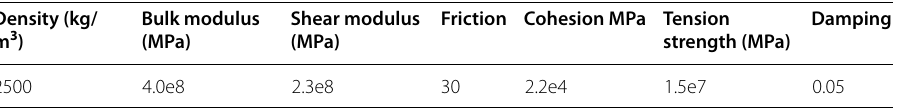
Table 1 Mechanical properties of